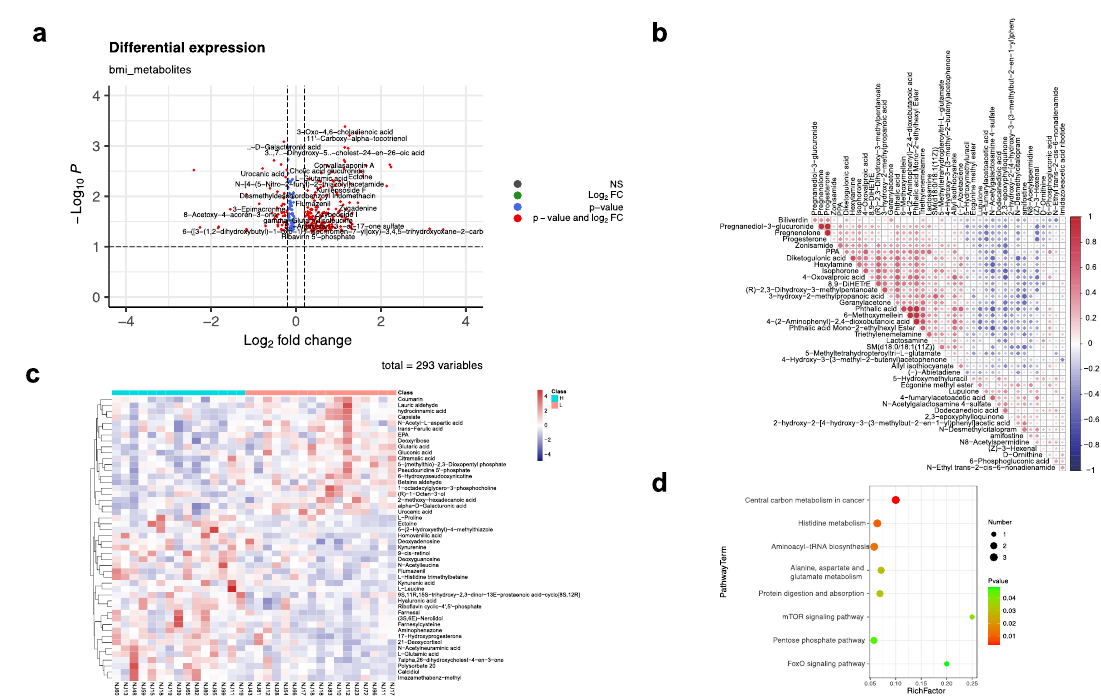
Figure 4. The differential metabolites in the high − and low − BMI groups. ( a ) The differential metabolites expression identified in the high − and low − BMI groups. The x axis shows the log2 fold change of the metabolites in two groups (high antibody group vs. low antibody group), and the y axis represents the − log10 p values of the metabolites. ( b ) The similarity of the differential metabolite distribution identified in the high − and low − BMI groups. ( c ) The heatmap of differential metabolites distribution in the high − and low − BMI groups. ( d ) The KEGG enrichment pathways of the differential metabolite distribution identified in the high − and low − BMI groups.